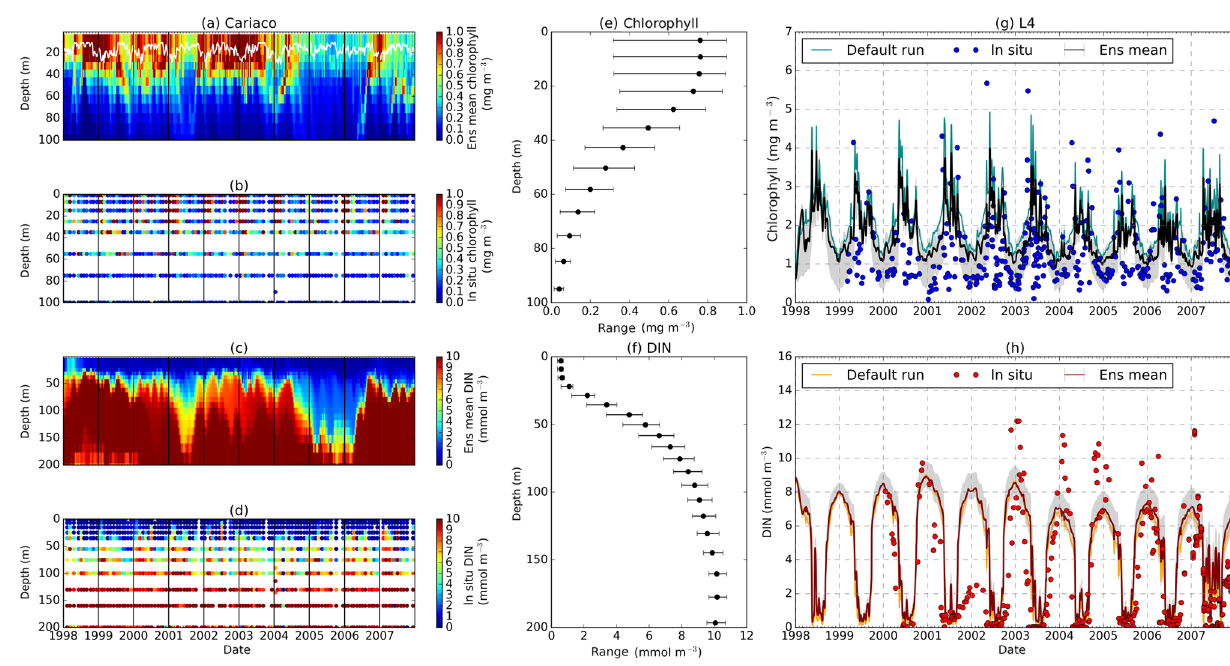
Figure 14. Time series of the chlorophyll and DIN profiles of the ensemble mean, their range, and in situ concentrations at the coastal stations Cariaco (a–f) and L4 (g–h) from January 1998 to December 2007. Panels (a) and (c) show the chlorophyll and DIN ensemble mean at Cariaco respectively. The white solid line in (a) is the mixed layer depth. Panels (e) and (f) show the 75th and 25th percentile of chlorophyll and DIN concentrations at each depth. The black dots are the mean of the ensemble. These ranges are obtained from the 10-year mean concentrations at each depth. Since in situ chlorophyll and DIN were taken at the surface in station L4, only surface time series were shown in (g) – (h) . The grey shades on the chlorophyll, shown in (g) , and DIN, shown in (h) , time series show the 75th and 25th percentile of the range. The blue and red dots are in situ concentrations for chlorophyll and DIN